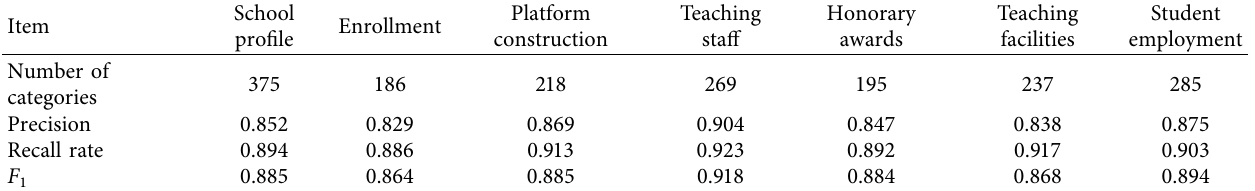
Table 2: Statistical results of educational information classification based on support vector machine classification model.